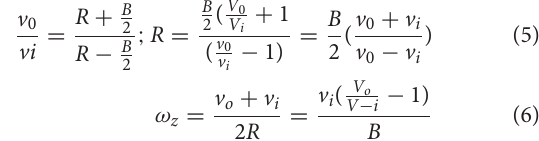
The last equation in (4) is used to express the natural frequency associated with the suspension